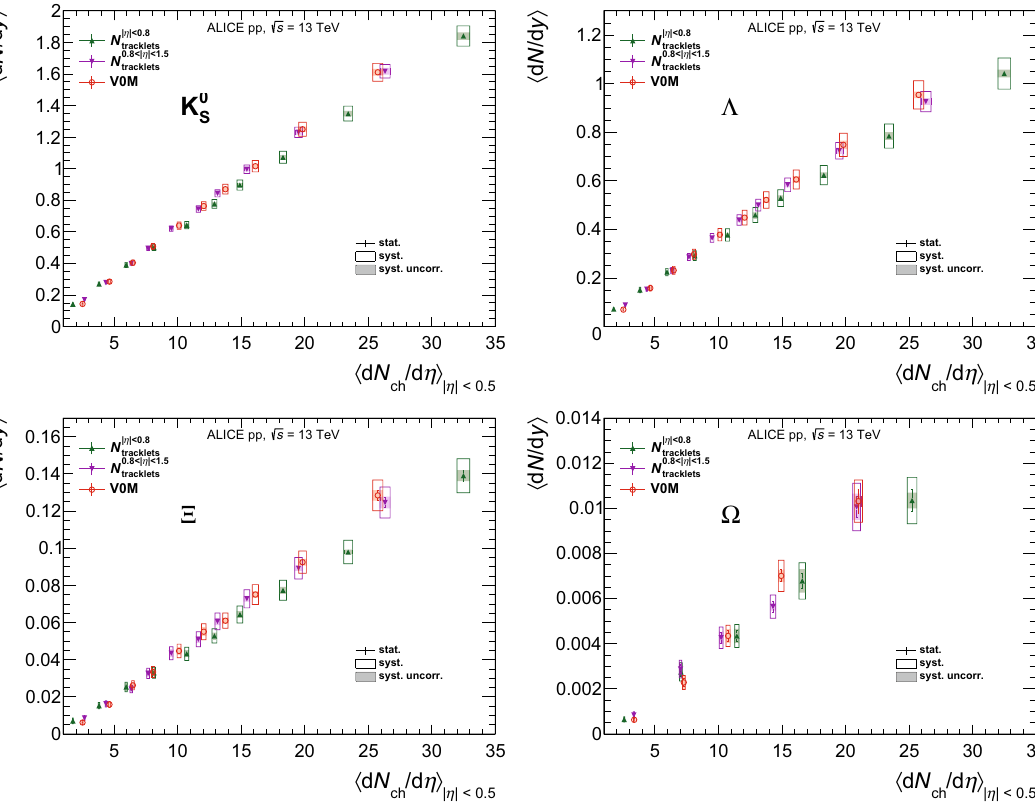
Fig. 8 d N / d y (integrated over the full p T range) as a function of mul- tiplicity for different strange particle species reported for different mul- tiplicity classes (see text for details). Error bars and boxes represent